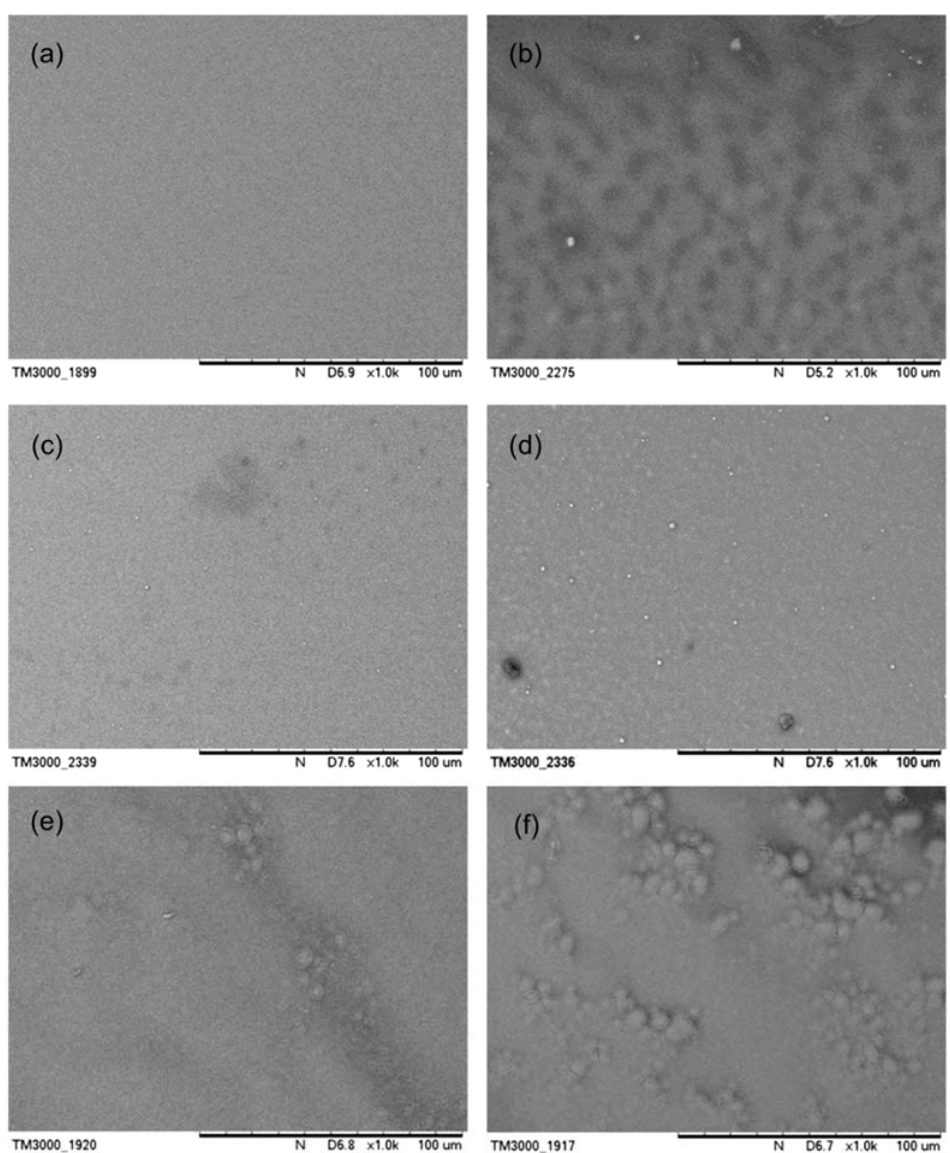
Figure 8. SEM images of ( a ) pristine PFO film, ( c ) 97:3 aggregated PFO film and ( e ) 91:9 aggregated PFO film, respectively, before the thermal degradation test. SEM images of ( b ) pristine PFO film, ( d ) 97:3 aggregated PFO film and ( f ) 91:9 aggregated PFO film, respectively, after thermal degradation test.